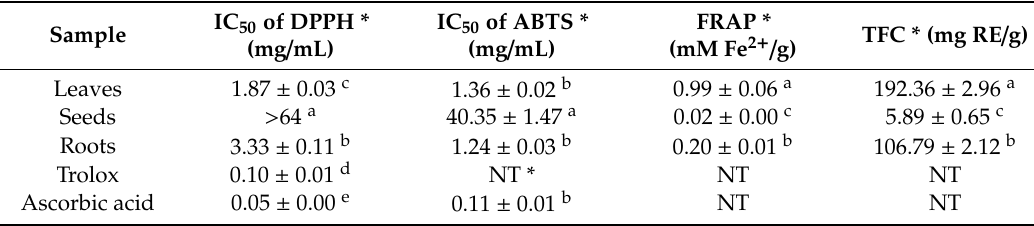
Table 1. Total flavonoids content and their corresponding antioxidant activity of M. oleifera .